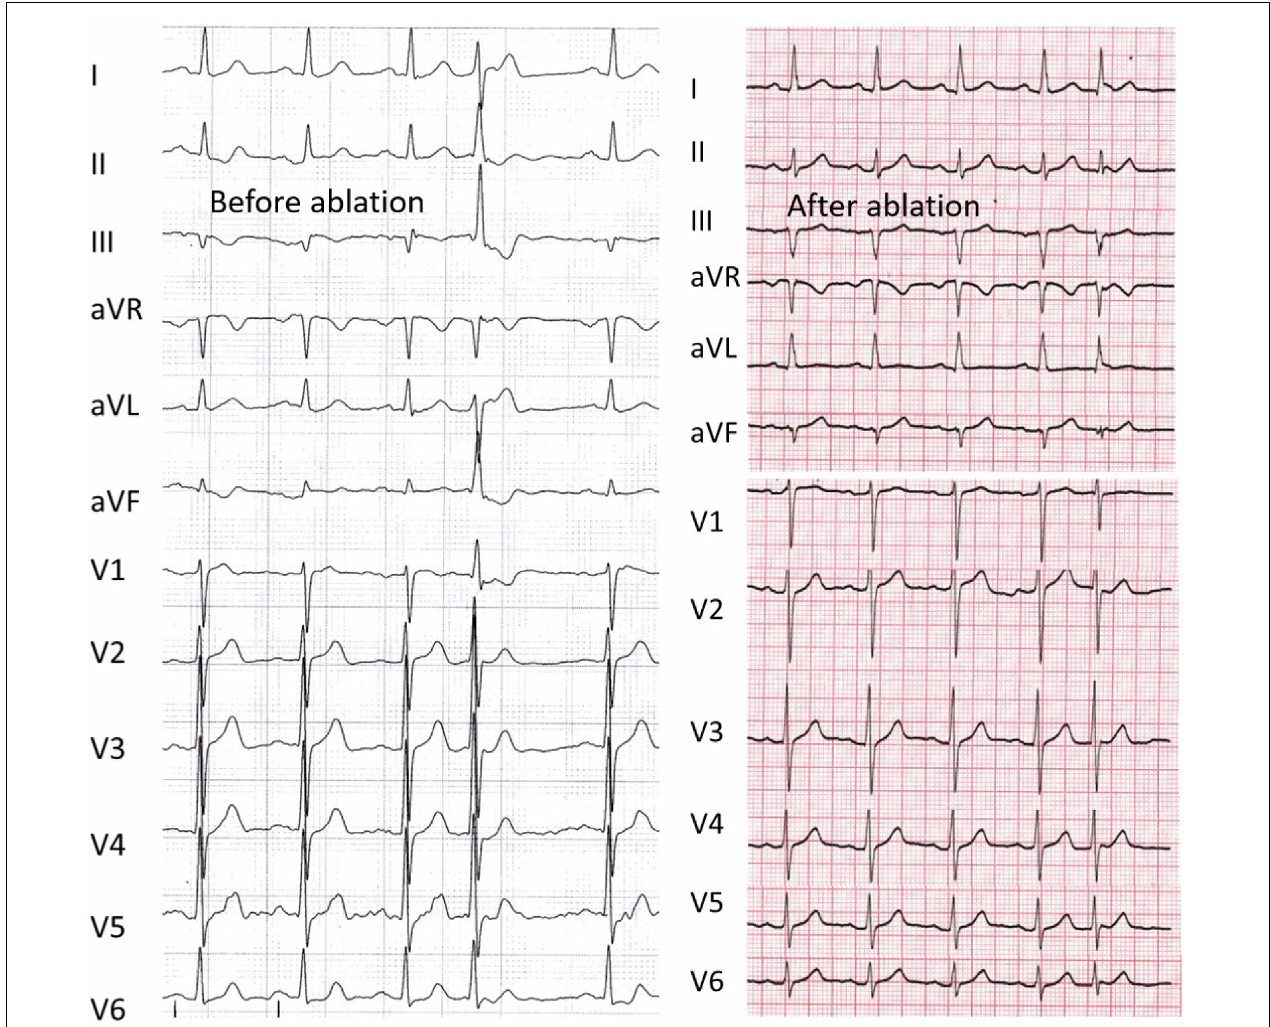
FIGURE 3 | An example of a failed case that refused more procedures (Patient 5). Left panel, the axis deviation was 45 ◦ before ablation, and radiofrequency energy was delivered at the distal site. Right panel, the patient had recurrence after the index procedure, the QRS duration ratio of NSR/PVC after ablation increased from 0.68 to 0.93, and the axis deviation increased to 58 ◦ . The abbreviations are as in Figure 2